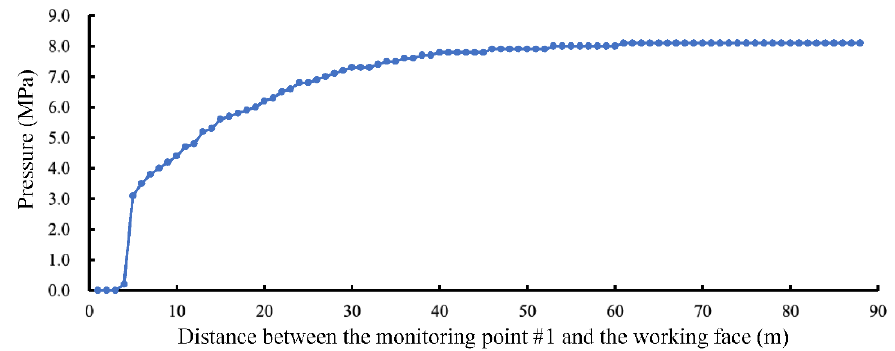
Figure 12. Stress profile of backfilled pier-column from monitoring point #1.